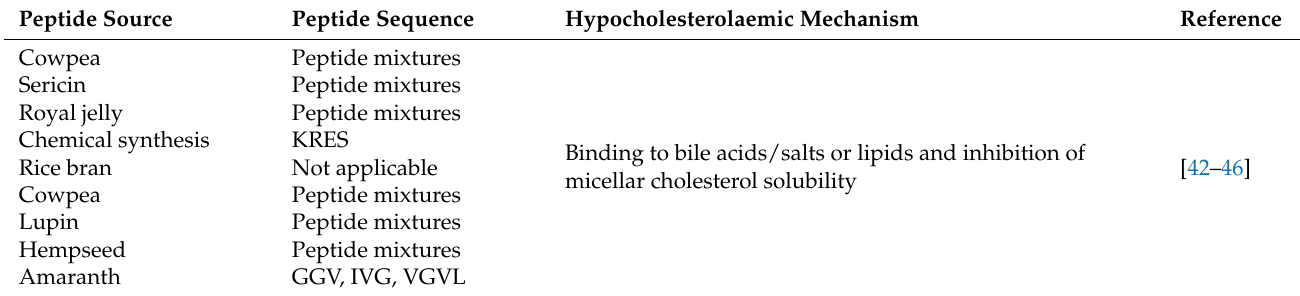
Table 2. Cholesterol-lowering peptides. Mechanisms underlying the hypocholesterolaemic activity of peptides. Peptide